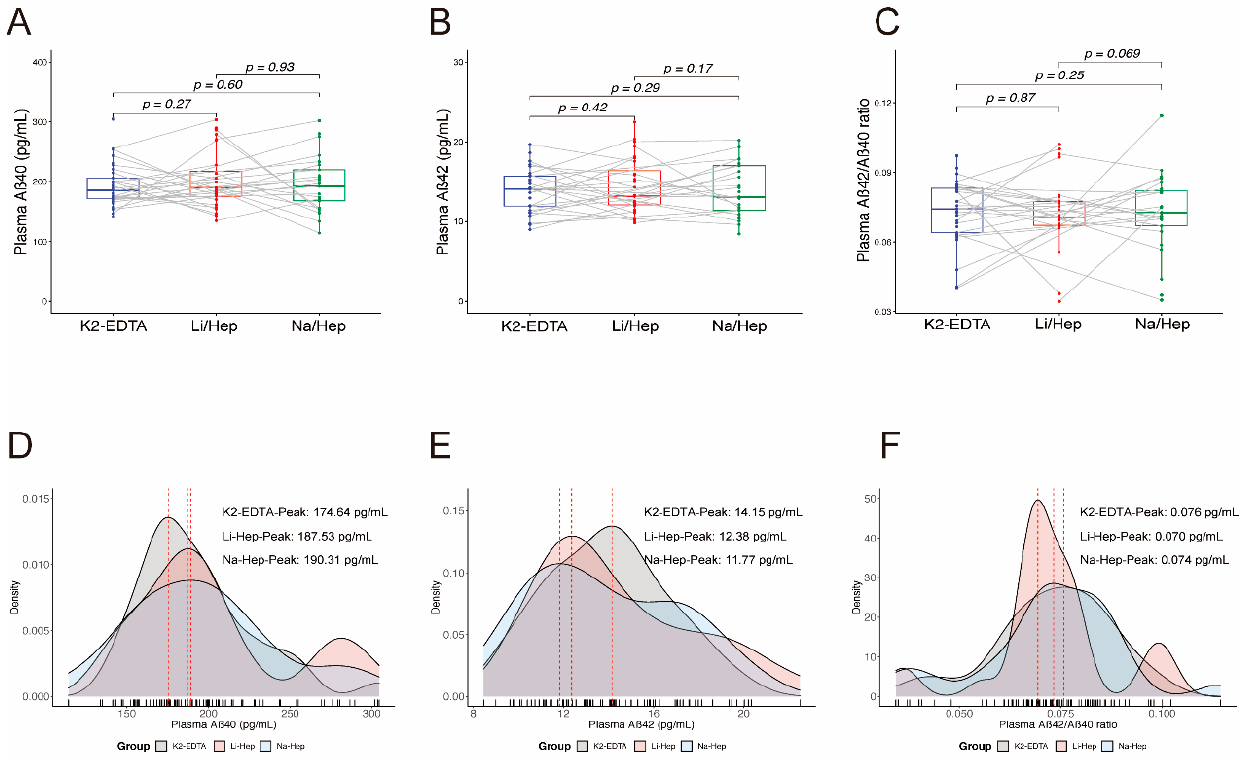
Figure 2. Blood collection methods do not affect the detection of A β levels. ( A – C ) AD biomarkers comparison among K2-EDTA, Li-Hep, and Na-Hep tubes including A β 40 ( A ), A β 42 ( B ), and A β 42/40 ratio ( C ); ( D – F ) Density plot of A β 40 ( D ), A β 42 ( E ) and A β 42/40 ratio ( F ) among K2-EDTA, Li-Hep, and Na-Hep tubes. ( A – C ): The differences between groups were assessed by paired t-tests; ( D – F ): The peak levels were calculated and statistically compared using the Kolmogorov–Smirnov test. n was indicated in the methods and Table 1.